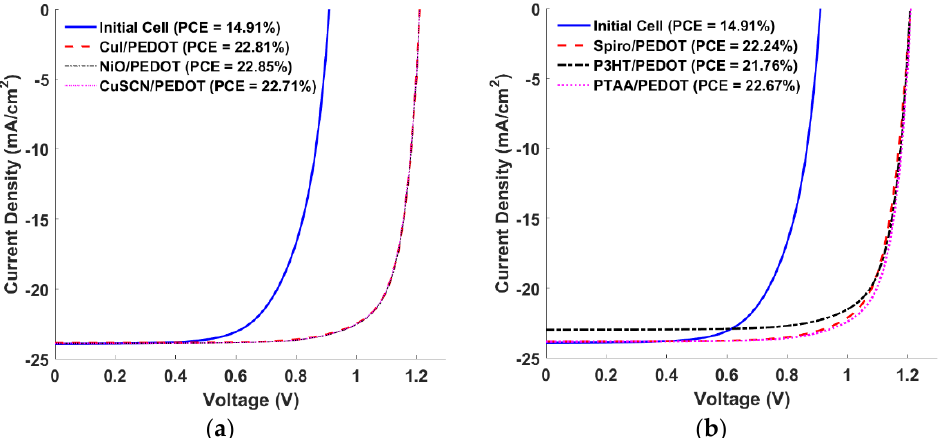
Figure 7. J-V curves for different double HTL materials ( a ) Inorganic/PEDOT and ( b ) Organic/PE- DOT.